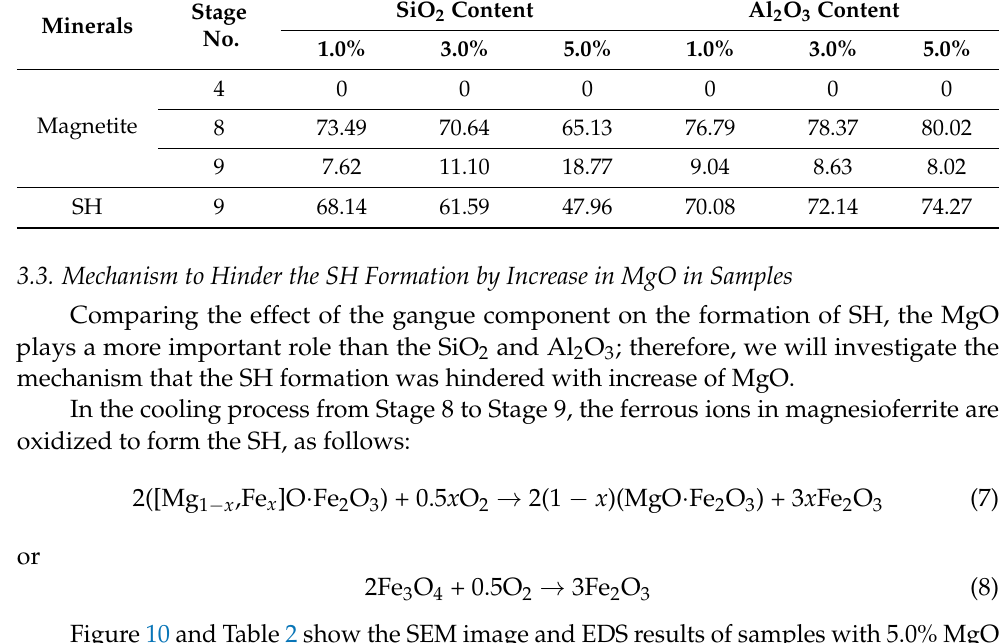
Figure 10 and Table 2 show the SEM image and EDS results of samples with 5.0% MgO at different stages. Comparing the chemical composition of elements and electronic scatter- ing color of mineral phases at Stage 4 (Stage 6) to Stage 9—as shown in Figure 10a–d, with the corresponding XRD patterns shown in Figures 4 and 5, and the optical microstructure shown in Figure 6d—it can be seen that only two phases existed in the sintering process, where the grey phase is hematite without an Mg element, while the dark-grey phase is magnesioferrite with an Mg element, which also confirmed that MgO completely